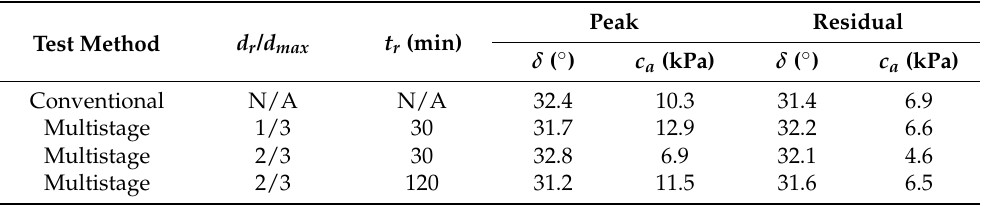
Table 5. Peak and residual interface shear strength